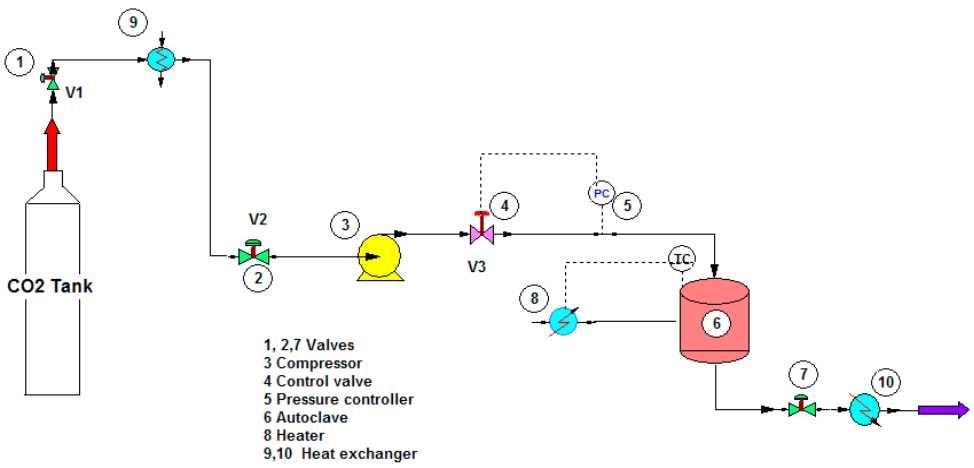
Figure 2. Shemetic representation of the drug loading experiment under supercritical carbon dioxide.